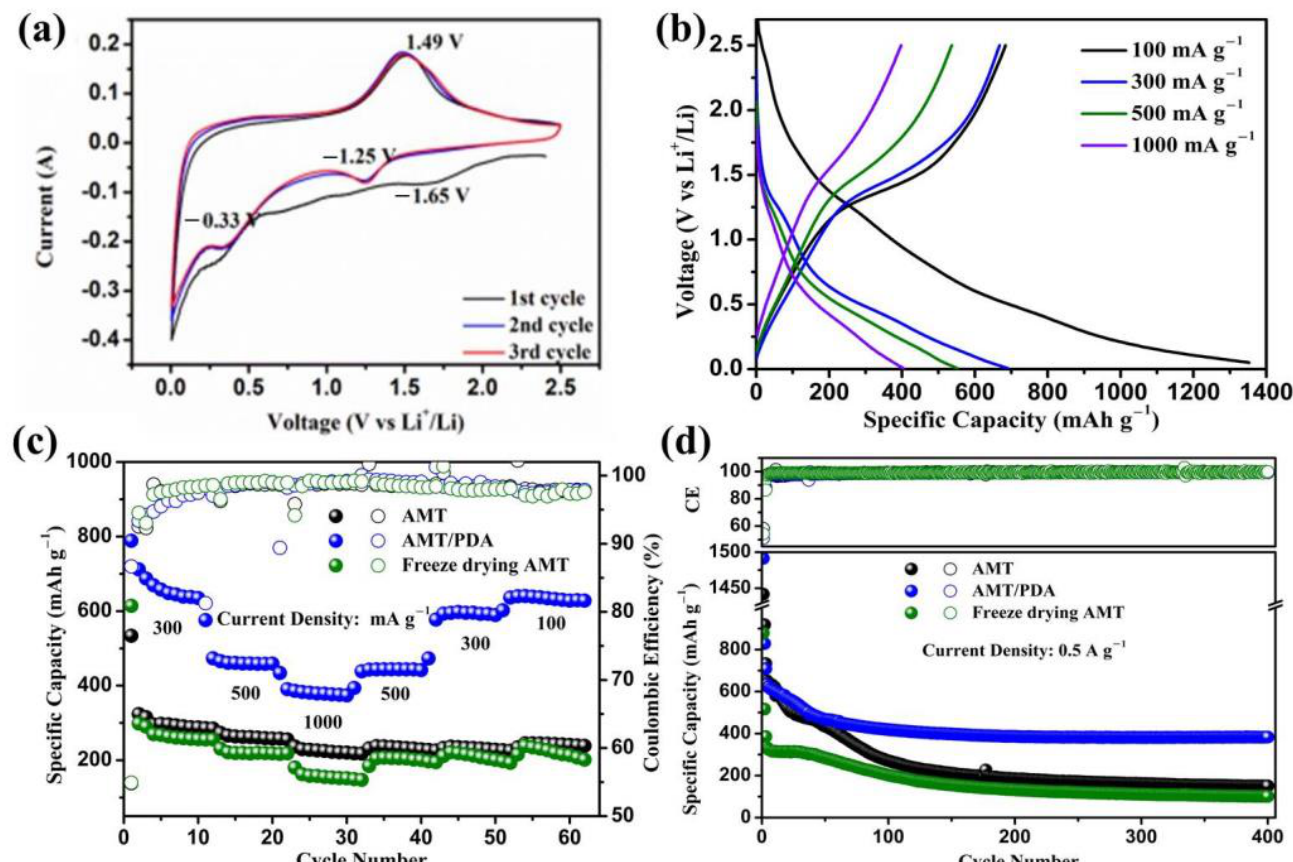
Figure 2. ( a ) Cyclic voltammetry curves of the AMT/PDA electrode from 0.005V to 2.5 at a scanning rate of 0.1 mV s − 1 , ( b ) Charge-discharge voltage profiles of the AMT/PDA electrode, ( c ) Rate capability, ( d ) cycling performances of the AMT, AMT/PDA, and freeze dried AMT electrode